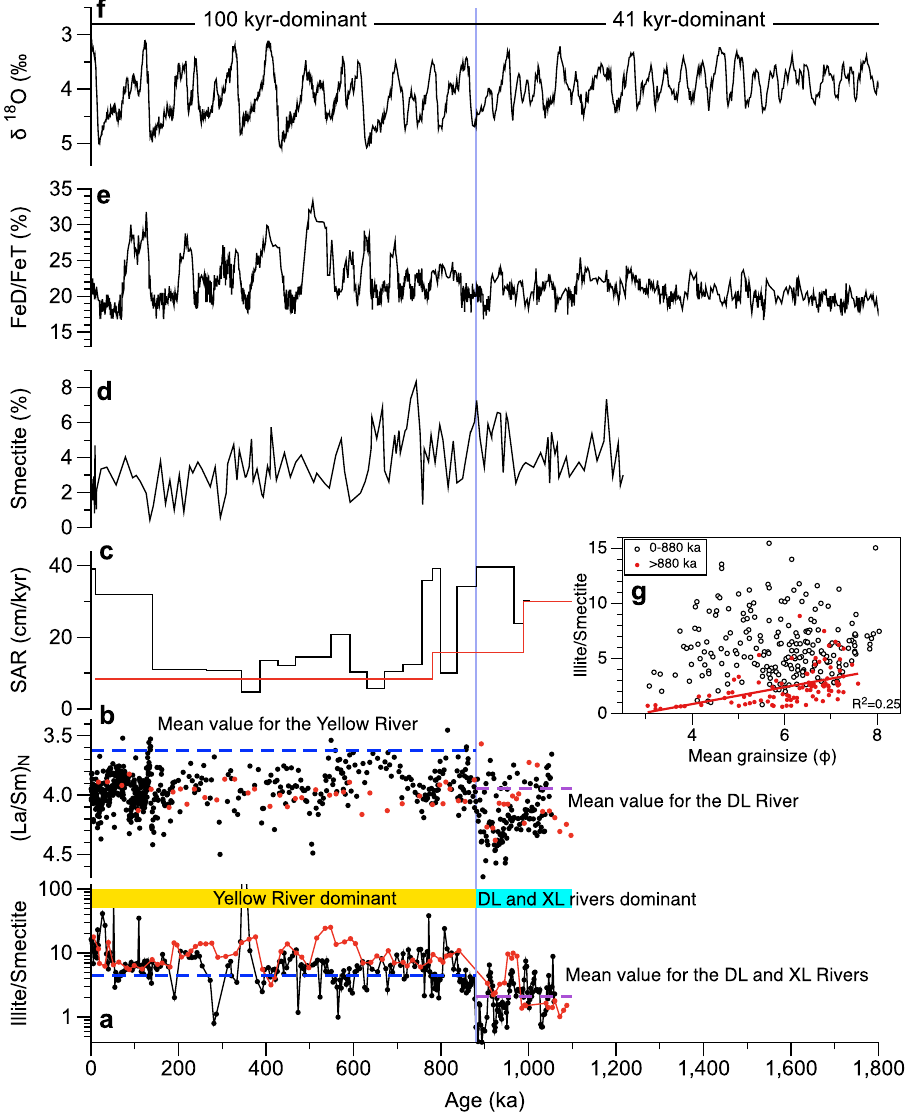
Figure 5. Comparison of proxies for cores BH08 (black) and NHH01 (red) with paleoclimate records. ( a ) Illite/ smectite. ( b ) Chondrite-normalized La/Sm ratio. ( c ) Sedimentary accumulation rate (SAR) for cores BH08 17 and NHH01 16 . ( d ) Smectite content for Lingtai section 40 . ( e ) Stacked FeD/FeT ratio from loess-soil sequence in northern China 56 . ( f ) Stacked marine oxygen isotope 68 . ( g ) Correlation between illite/smectite and mean grainsize for core BH08. Mean values of illite/smectite for the Yellow River 72 , Daling (DL) and Xiaoling (XL) rivers 30 are plotted as horizontal lines in panel ( a ), and La/Sm for the Yellow River 35 and Daling River 36 in panel ( b ). Vertical line denotes the age boundary of ~880